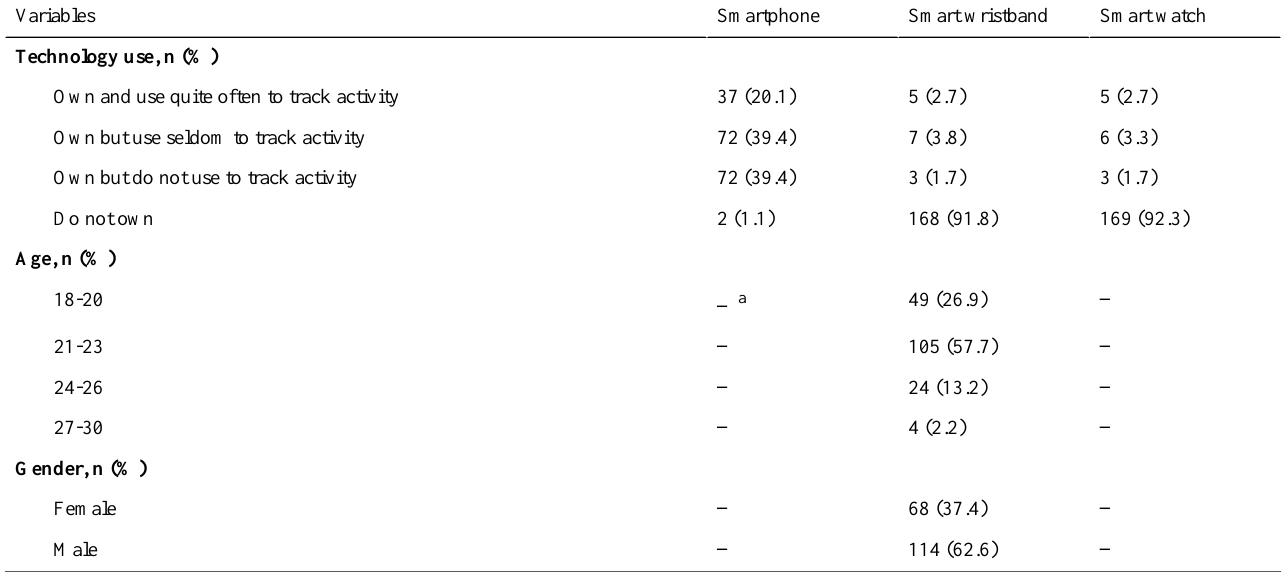
Table 2. Sample characteristics